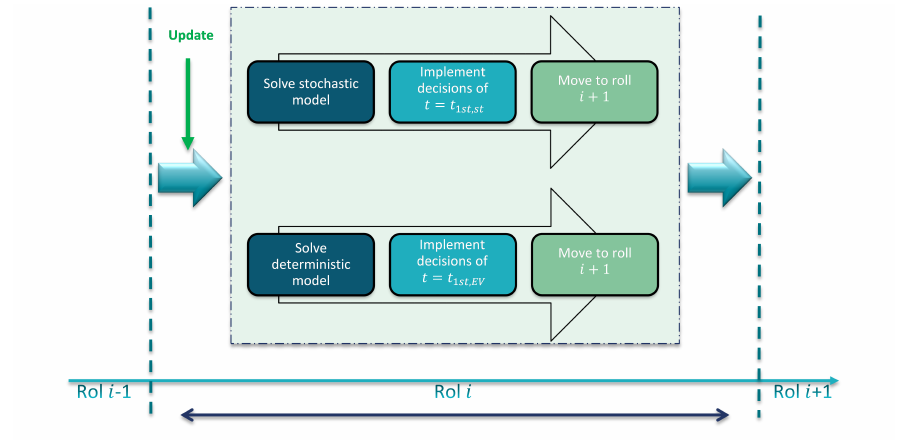
Figure 5. The simulation framework for the comparison of the optimisation methods.